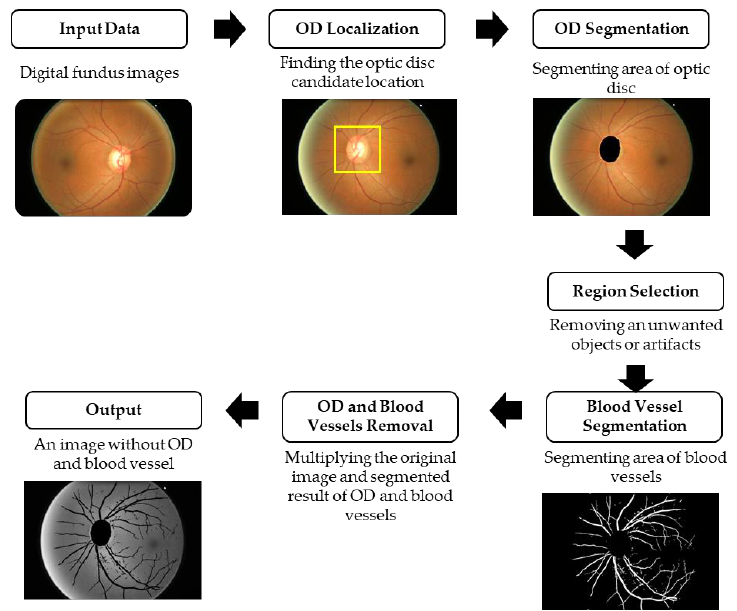
Figure 3. The scheme of preprocessing process.